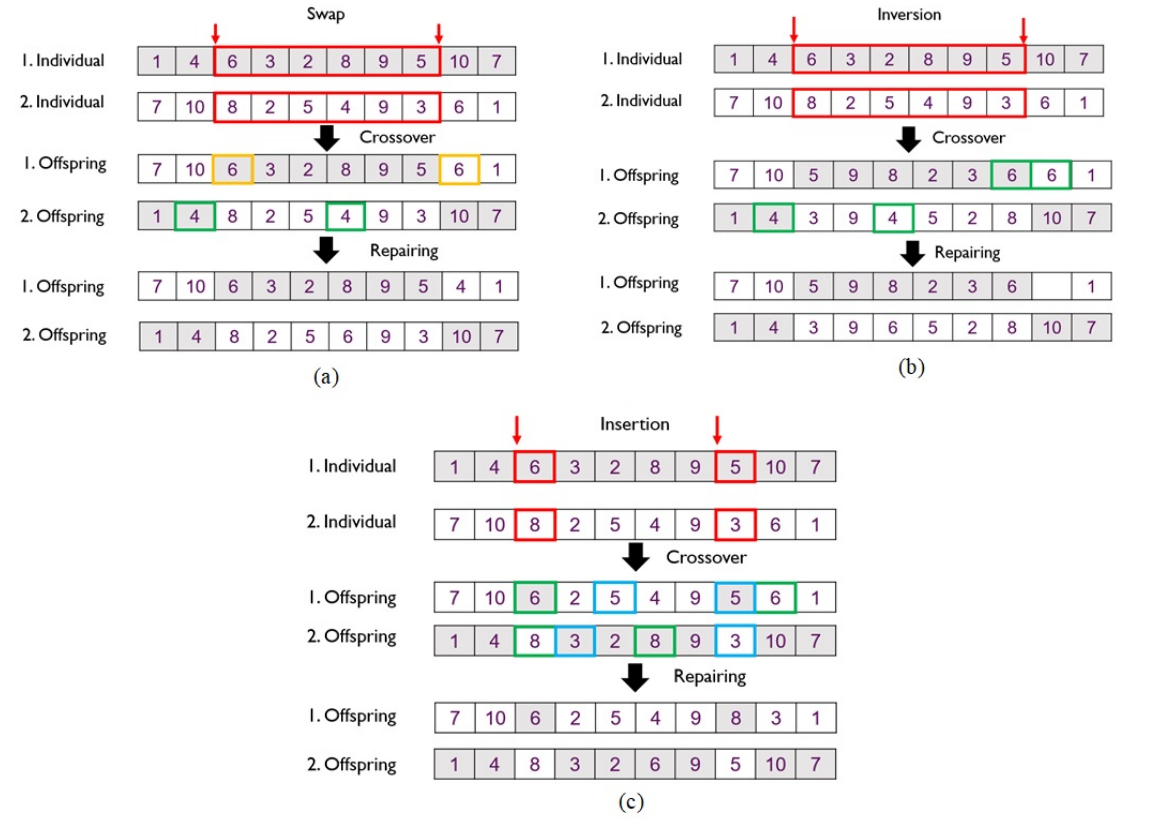
Fig. 4. Crossover operations (a) swap, (b) reversion, and (c) insertion